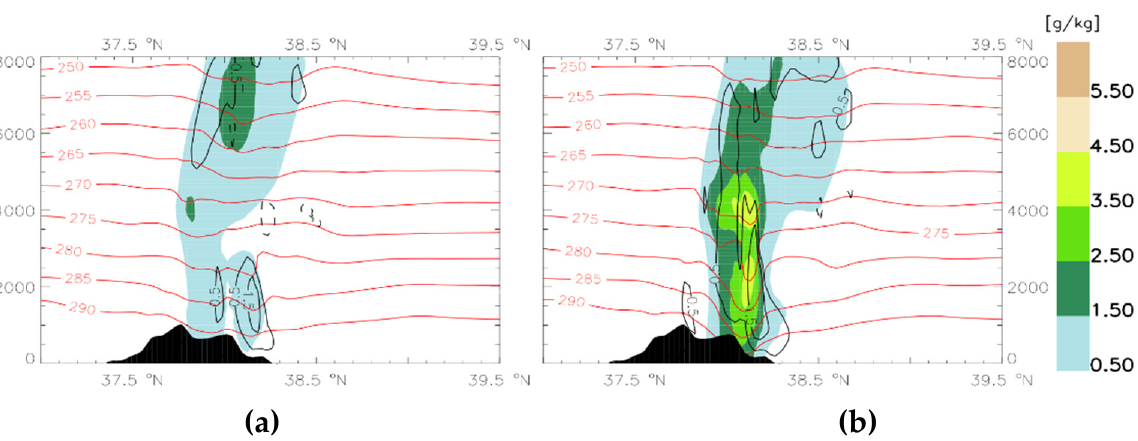
Figure 11. As in Figure 10 for: ( a ) LIGHT; ( b ) RL. Both panels are at 16:00 UTC.